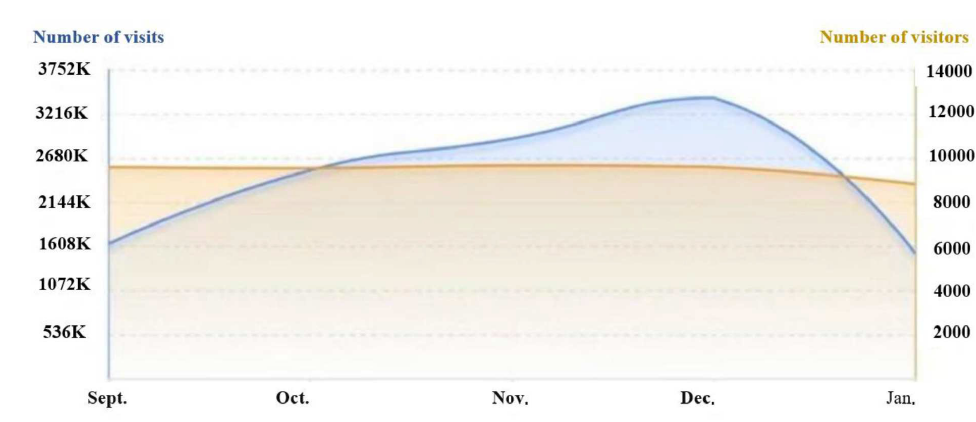
Fig. 6 Application of the platform in the first semester of the 2021–2022 academic